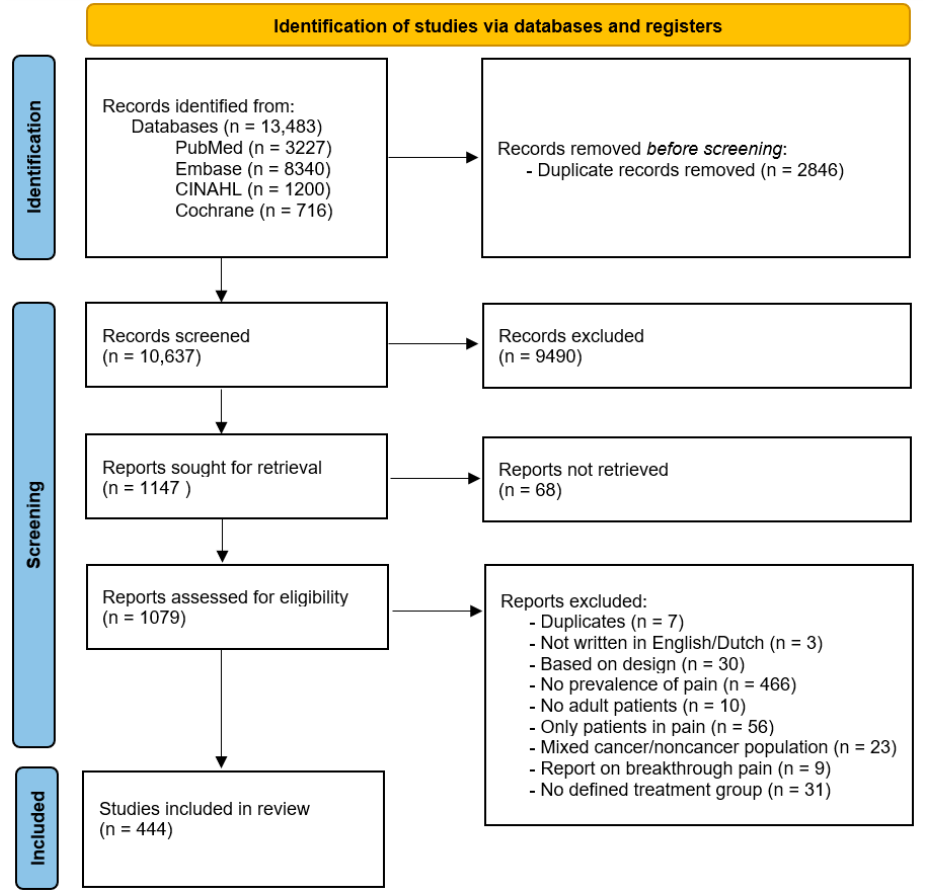
Figure 1. PRISMA flow diagram of study selection.